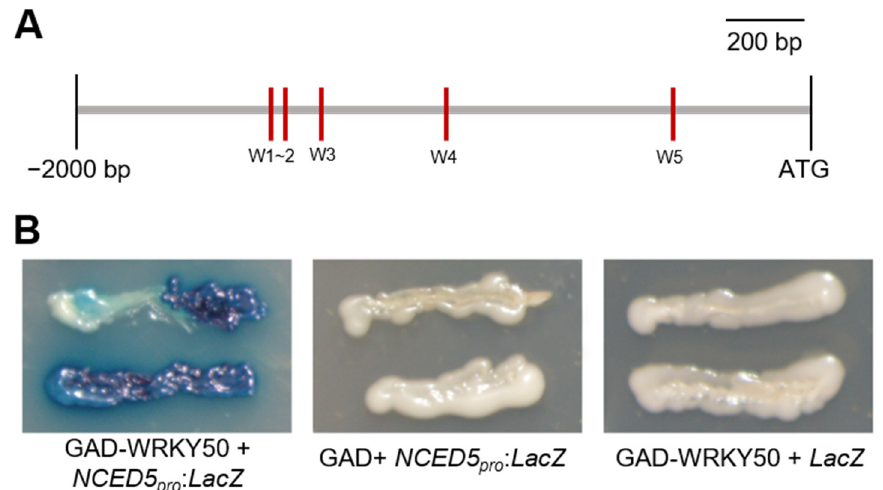
Figure 8. OsWRKY50 directly binds to the promoter of OsNCED5 . ( A ) Schematic diagram of OsNCED5 promoter. The W-box cis -elements (W1–W5) are shown in red boxes. Bar, 200 bp. ( B ) GAD-WRKY50 or GAD alone was transformed into the yeast strain EGY48 together with OsNCED5 pro :LacZ . Subsequently, transformants cultured on SD/-Trp-Ura plates were transferred and grown on SD/-Trp-Ura medium containing X-gal at 30 ◦ C for three